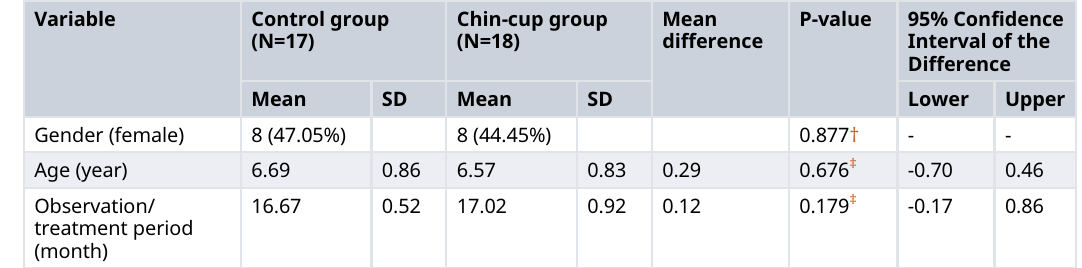
Table 4. Baseline sample